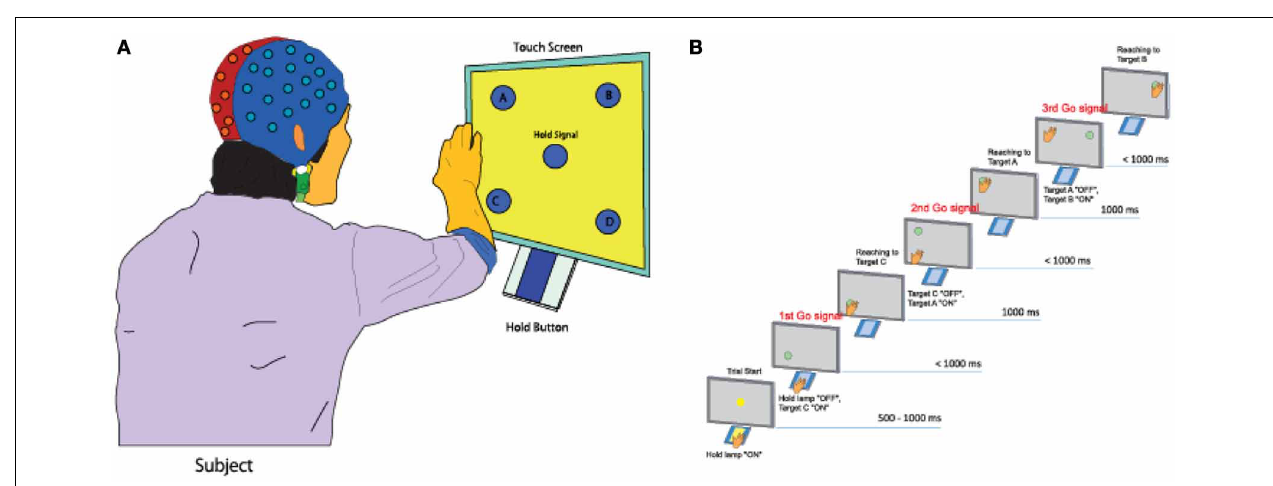
FIGURE 1 | Experimental task. (A) A subject performs a continuous arm-reaching task while facing a touch screen displaying five lights and five buttons. (B) Sequential arm-reaching task (Hold-C-A-B sequence).